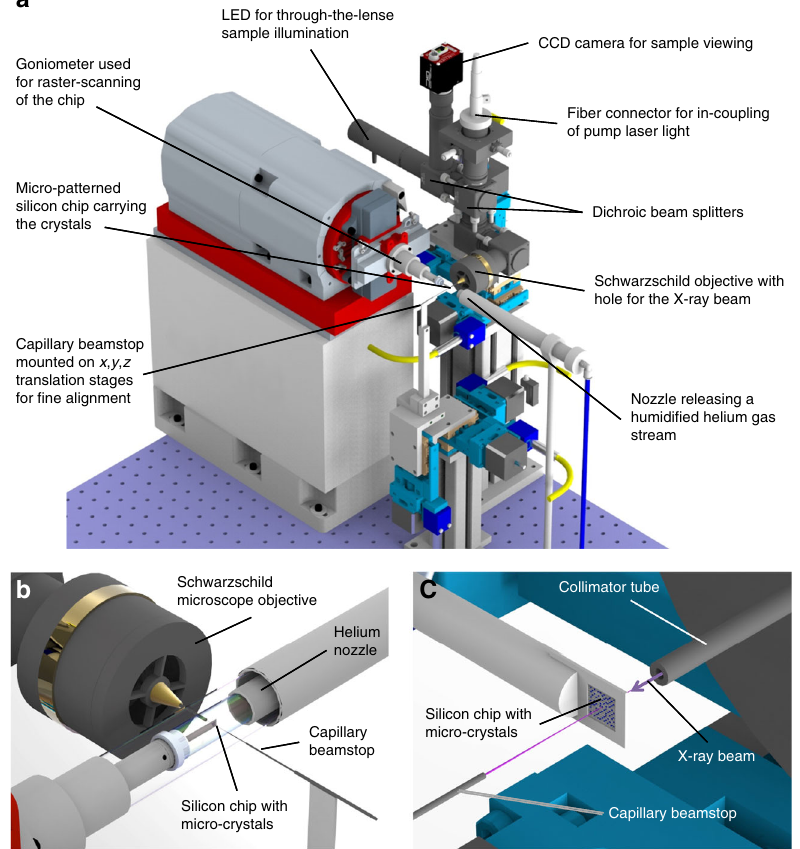
Fig. 7 a Experimental setup installed at the BioCARS instrument at the APS for fi xed target serial crystallography using the pink beam. The micro-patterned silicon chip is raster-scanned through the X-ray beam using the goniometer installed at the beamline. An inline microscope using Schwarzschild optics is used for sample visualization. It provides the opportunity of through the lense illumination for both sample visualization and laser excitation of the sample. b Close-up showing the chip mounted on the beamline goniometer and being exposed to a stream of humidi fi ed helium gas preventing the crystals from drying out. c Schematic view of phycocyanin crystals mounted onto a micro-patterned silicon chip. The short path of the direct beam between the collimator tube and the capillary beamstop behind the sample is highlighted in pink. By fl ushing the remaining free beam path with helium, extremely low background scattering levels are achieved. The drawings were created using the software Solid Edge ST8, KeyShot 5.0, GIMP 2, and Microsoft